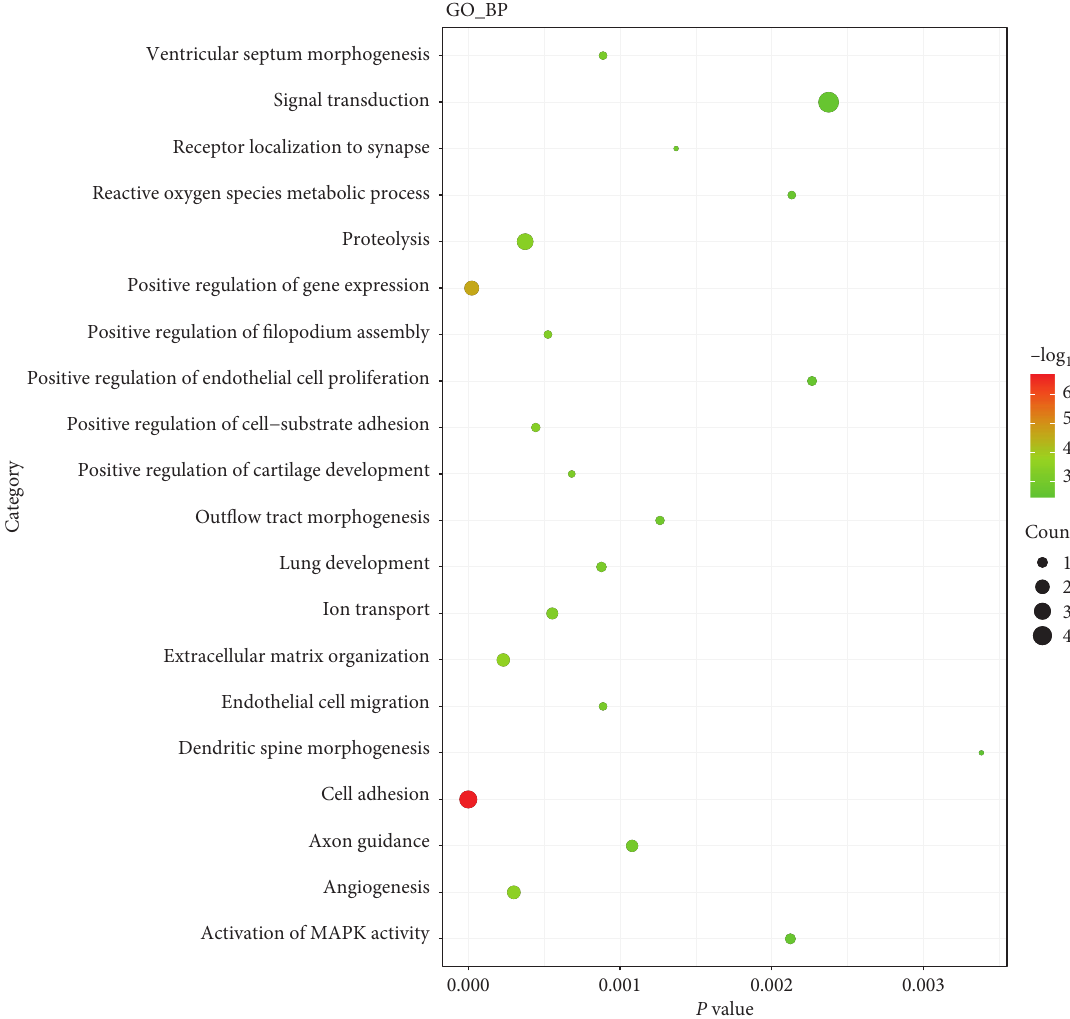
Figure 7: Top 20 significant enrichment BP terms of mRNAs in PTC based on GO enrichment